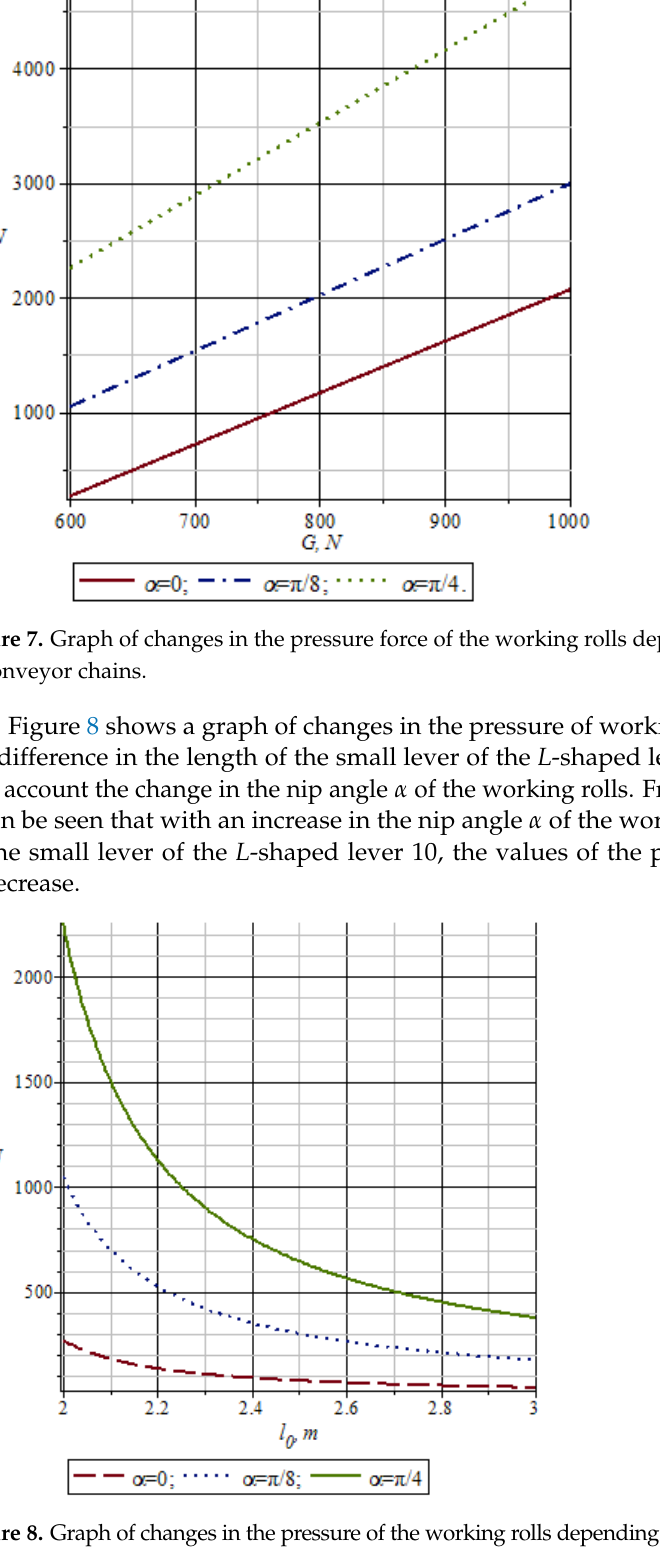
Figure 9. Graph of changes in the pressure of working rolls depending on their weight force. From the graph in Figure 9, it can be seen that with an increase in the weight force P of the material being processed and the nip angle α , the pressure values of working rolls Q decrease accordingly. Thus, it will be necessary to increase the pressure of working rolls Q for greater values of weight force P of the material being processed. Figure 10 shows the graph of changes in the pressure of working rolls Q depending on the change in the length of the lever l2 of the L -shaped lever and weight P of the mate- rial being processed, taking into account the difference in the friction coefficient f fr . From the graph in Figure 10, it can be seen that with an increase in the length of the lever l2 of the L -shaped lever, the values of the pressure of the working rolls Q increase.